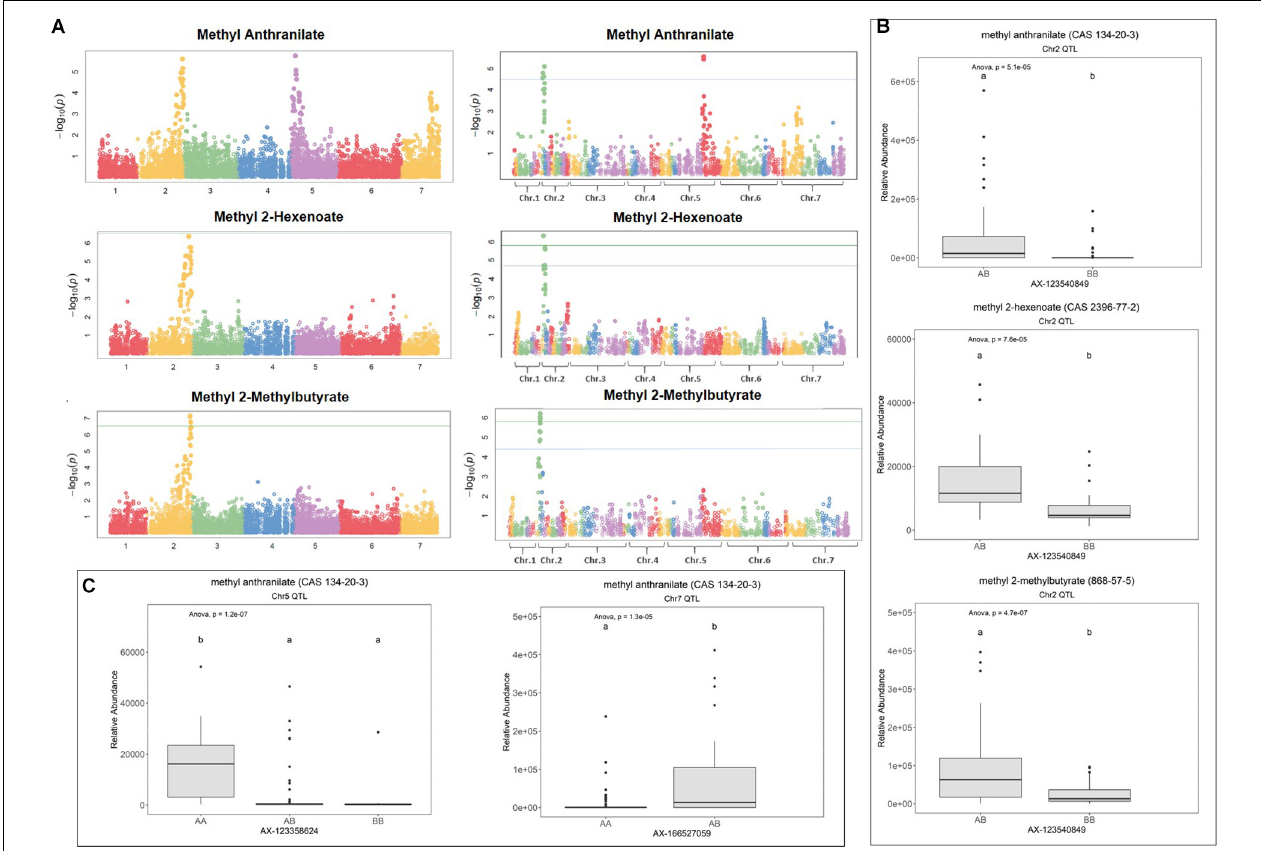
FIGURE 1 | Methyl ester QTL in strawberry fruit. (A) QTL Manhattan plots for methyl anthranilate, methyl 2-hexenoate, and methyl 2-methylbutryrate using the F. vesca physical map (left column) and the FL_08-10 × 12.115-10 genetic map (right column). (B) Effect sizes of a shared methyl ester QTL marker on Chr 2. Lowercase letters indicate statistically significance mean differences at p < 0.05 (ANOVA). (C) Effect sizes for the methyl anthranilate QTL on Chr 5 and the putative Chr 7